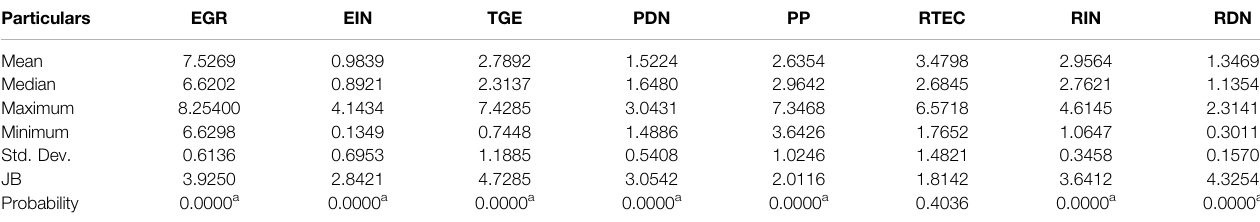
TABLE 2 | Descriptive statistics.